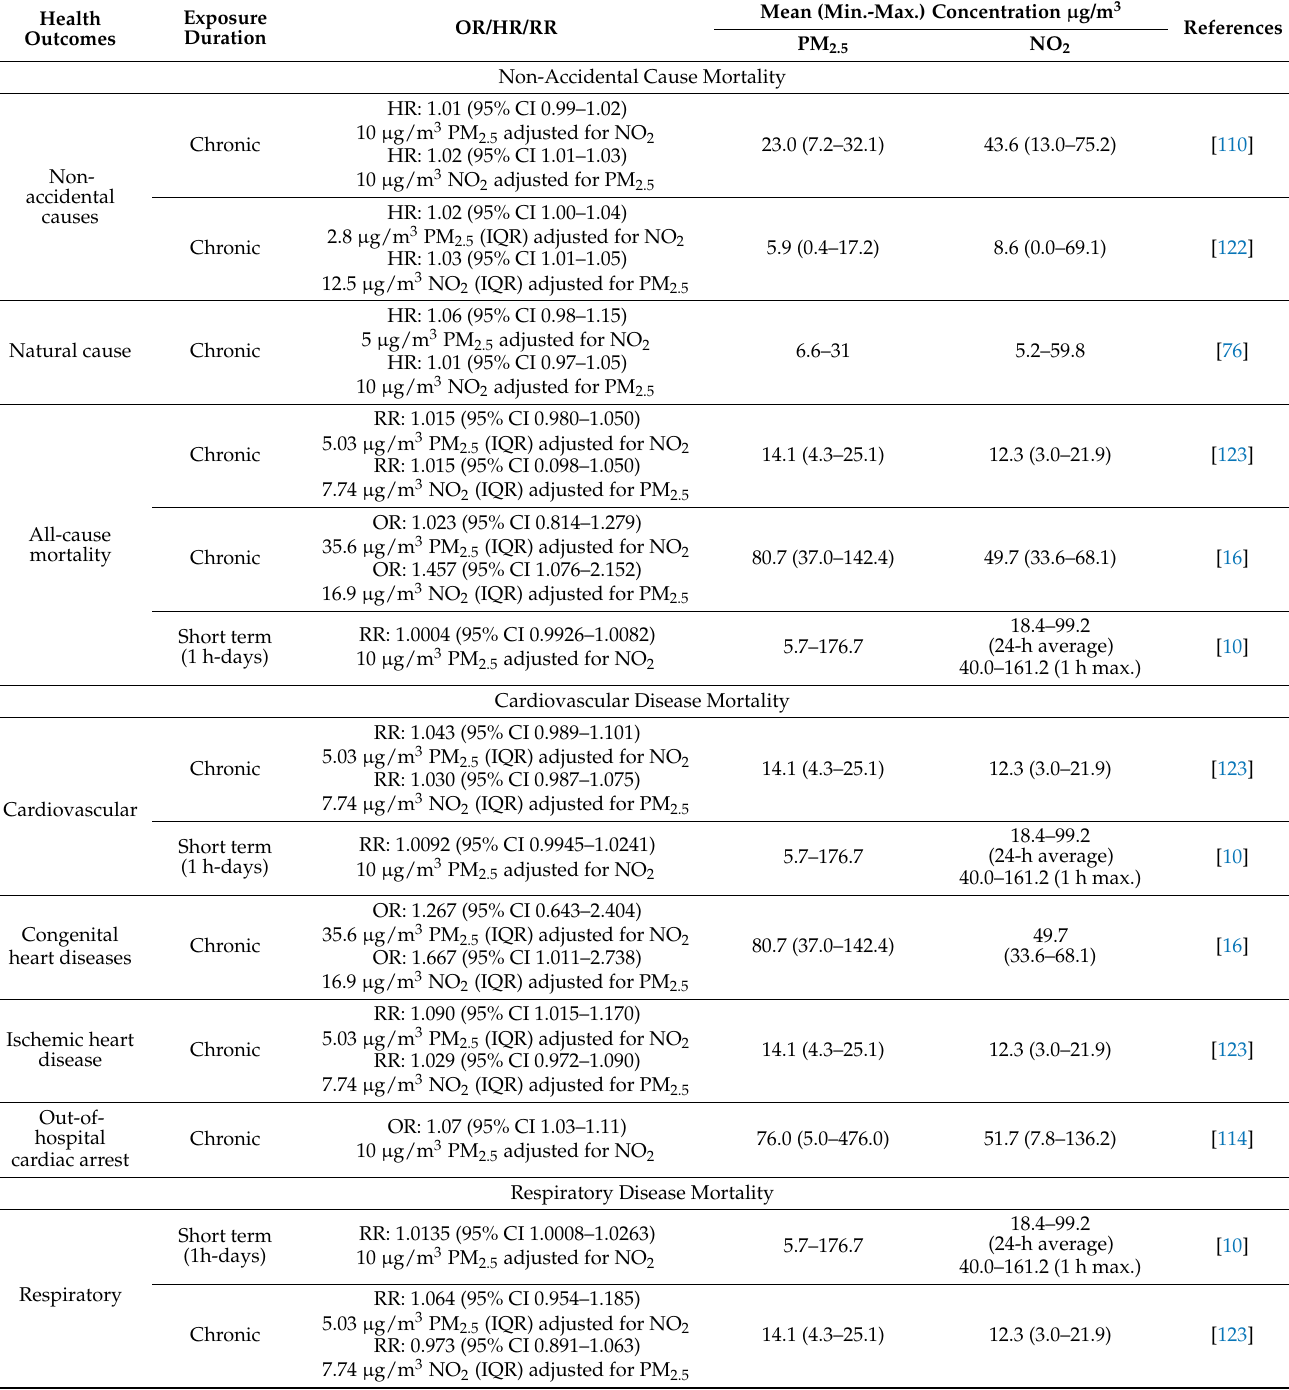
Table 3. Risk ratio (RR), odds ratio (OR), and hazard ratio (HR), and health effects linked to PM 2.5 and NO 2